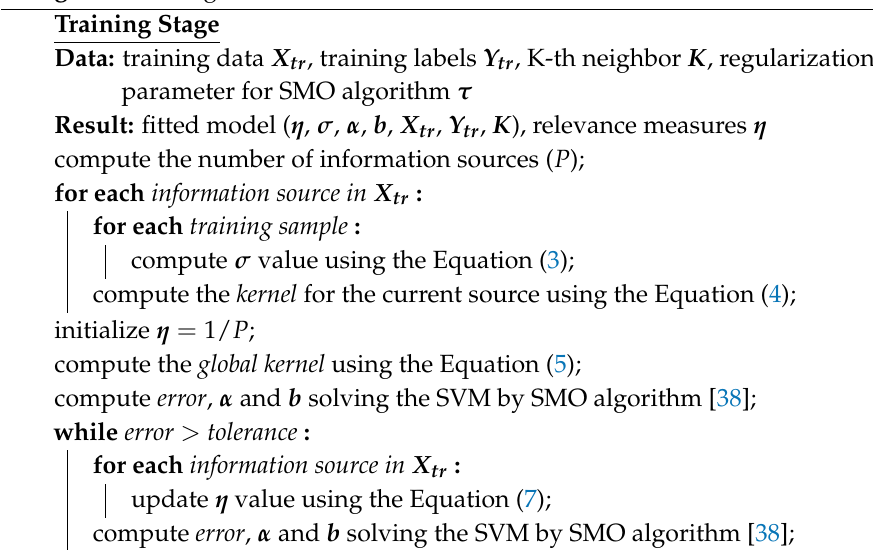
Algorithm 1: Algorithm without data reduction Training